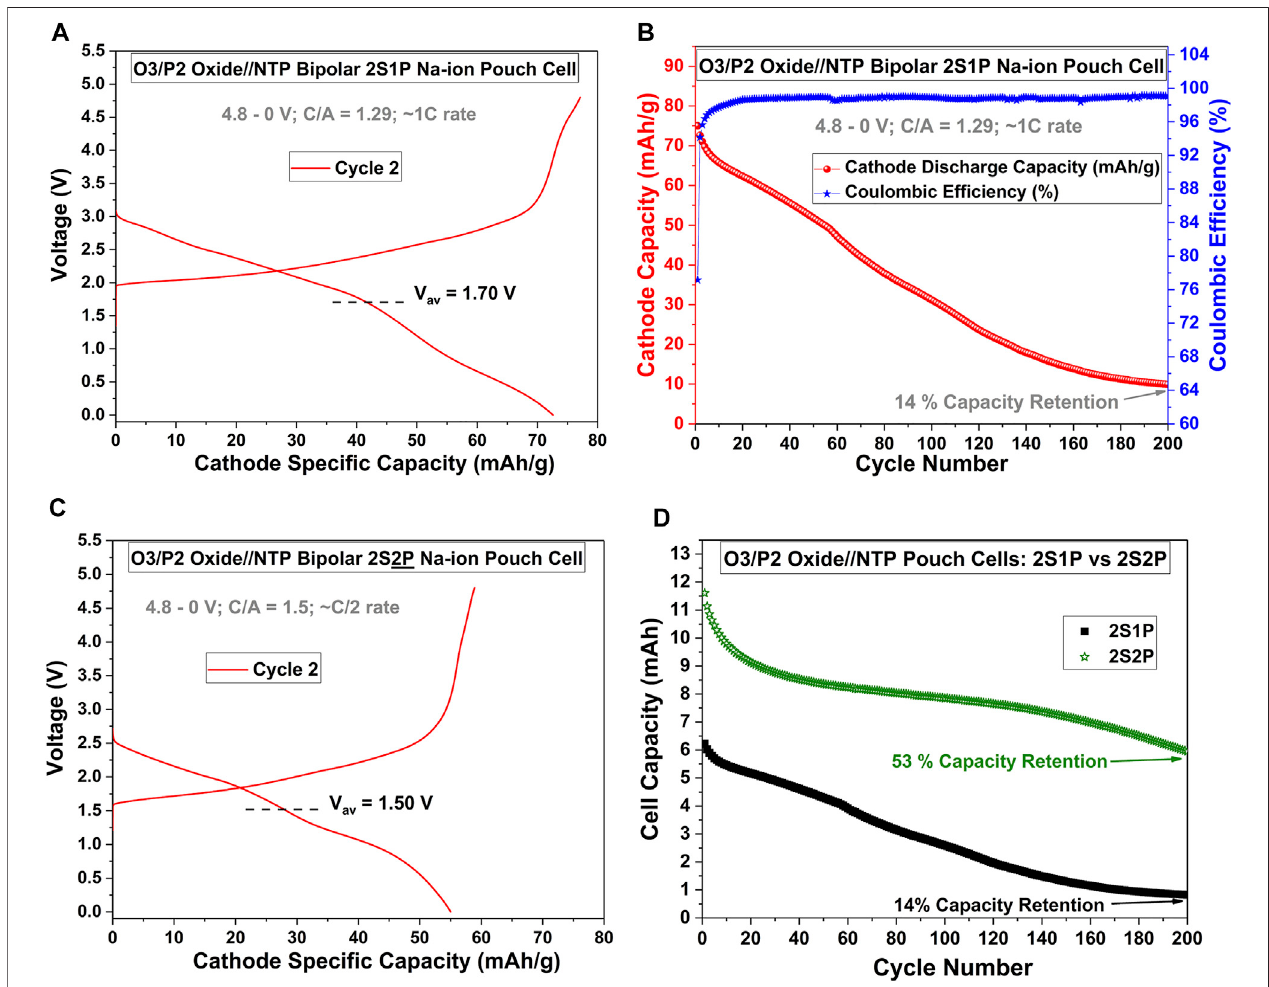
Figure S5 for the electrode stack picture for this cell). (D) Comparison of the cycle lives of the 2S1P and the 2S2P cells: it can be seen that the cell capacity of the 2S2P cell doubles.